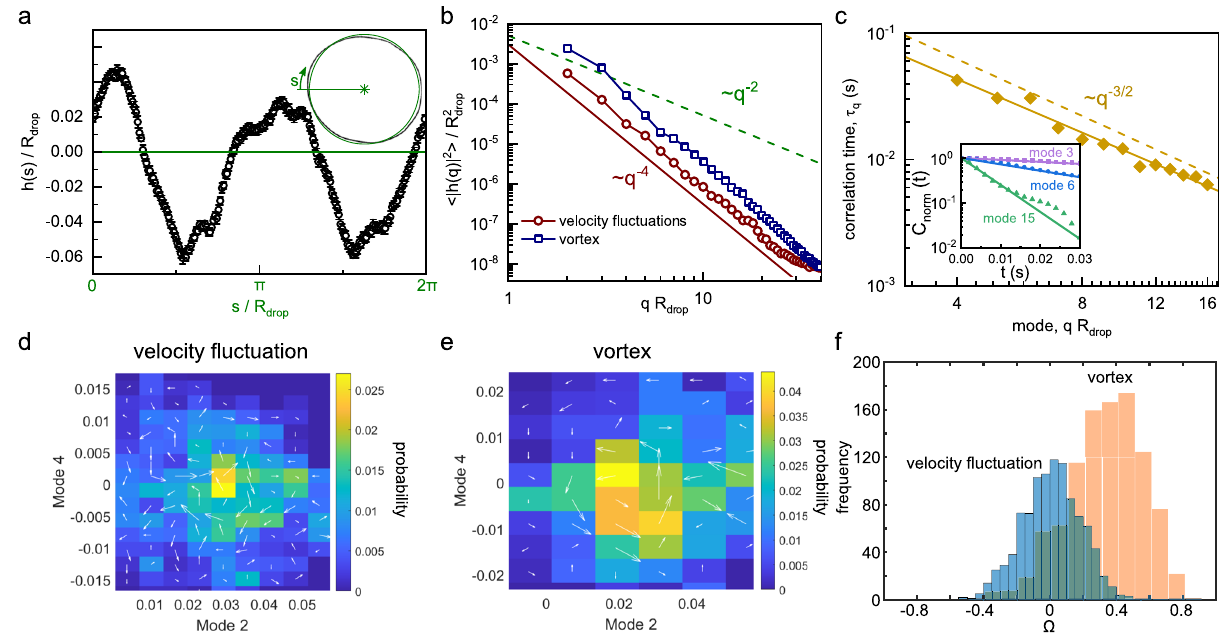
Fig. 3 Analysis of the shape fl uctuations. a A snapshot of the contour h around the equivalent circle radius R drop . The coordinate s runs along the circumference of the equivalent circle (inset, green). The liquid-air interface is deformed (inset, black) by the activity inside the droplet and deviates from R h . b A time-averaged power spectrum 〈 ∣ h ∣ 2 〉 dependence on the wave number q for two cases: fl uctuating velocity regime and fully developed drop by q vortex regime. In both cases the decay of the power spectrum falls off as q − 4 . c Relaxation time of the autocorrelations as a function of the wavenumber q . The inset shows the autocorrelation functions for three modes. The fi t of the data results in power law with exponent ≃ − 3/2 shown as a dashed line (the exact fi t gives the exponent − 1.41 ± 0.08 shown as a solid line). d , e Probability distribution (color) and fl ux map (arrows) in phase space spanned by Fourier modes 2 and 4 in d the velocity fl uctuation and e vortex phases. Arrows length corresponds to the magnitude of the fl uxes. The plots for the other modes are shown on Supplementary Fig. S6 and Fig. S7. f The contour integral of the probability current, Ω , histograms for d , e show different values in the velocity fl uctuations phase (blue, Ω = 0.01 ± 0.17) and vortex phase (orange, Ω = 0.32 ± 0.22). Error bars are the standard error of the mean. In b , c error bars are smaller than the